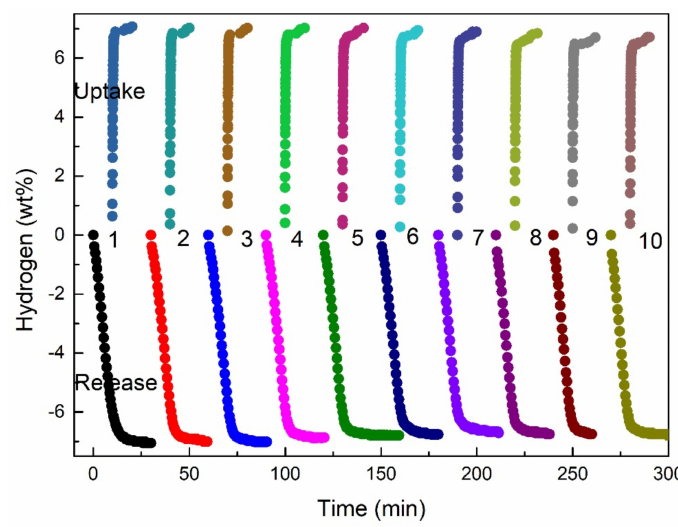
Figure 7. Cycling profiles of MgH 2 + 5 wt%- c -TiH 1.971 under dehydrogenation conditions of 300 ◦ C, and hydrogenation conditions of 300 ◦ C under 3 MPa H 2